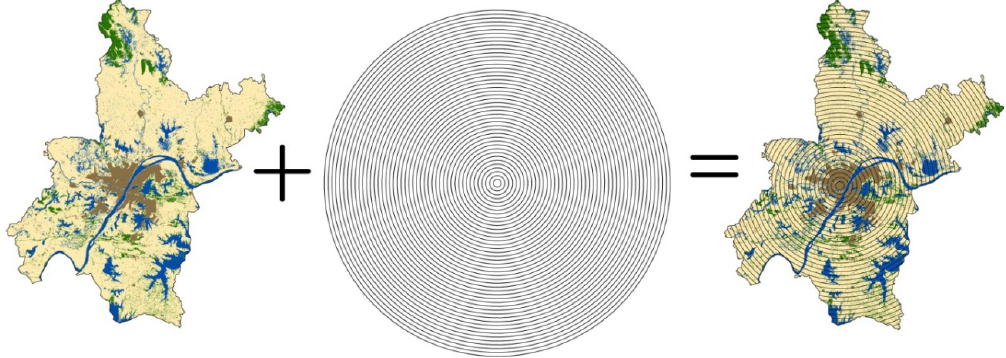
Figure 6. Buffer analysis used to identify area surrounding the given center within different